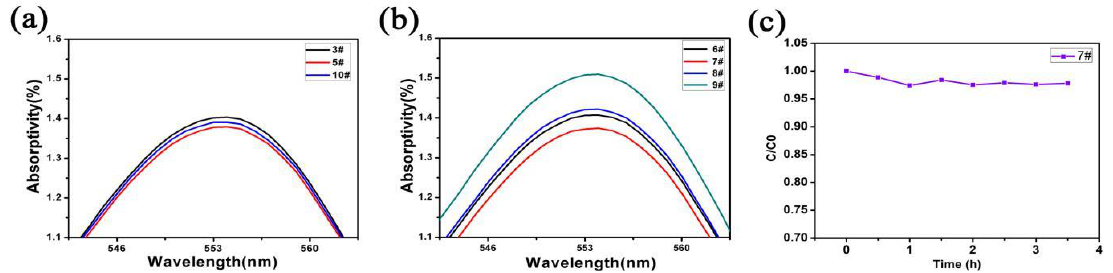
Figure 8. ( a ) The light absorption test of the solution after photocatalysis by 3#, 5#, and 10#; ( b ) the light absorption test of the solution after photocatalysis by 6#, 7#, 8#, and 9#; ( c ) continuous photocatalytic test of 7 # sample.